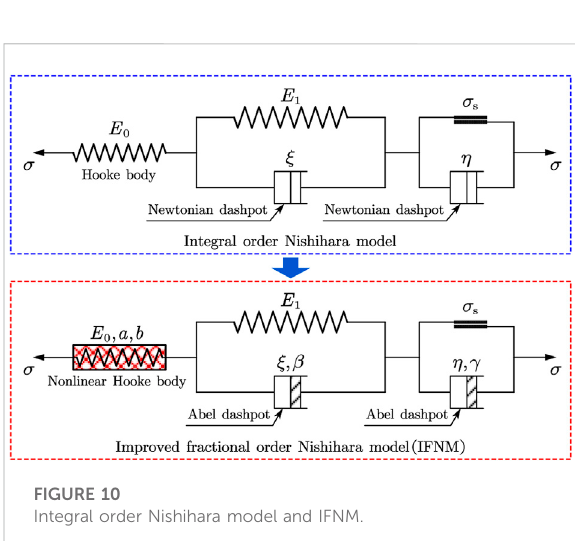
FIGURE 10 Integral order Nishihara model and